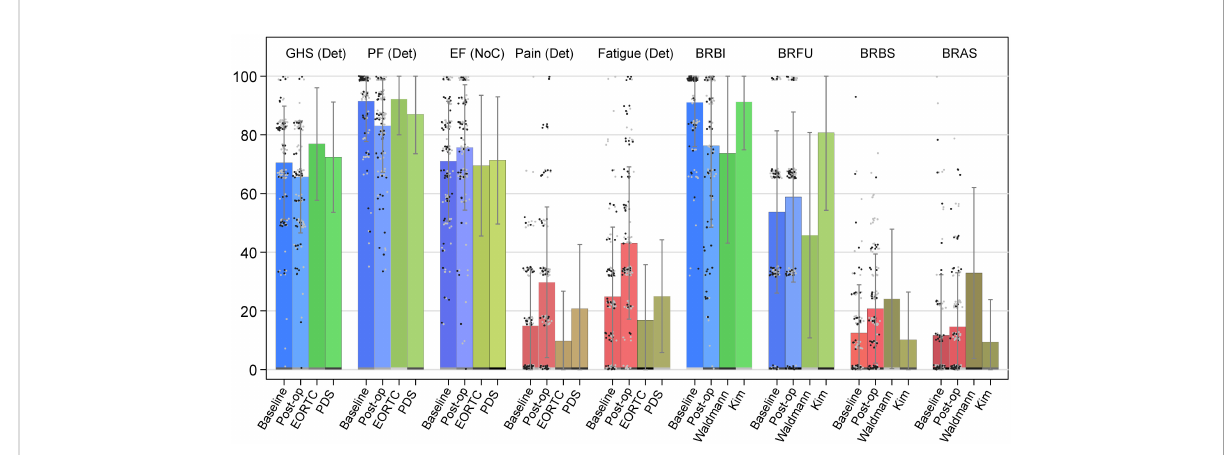
FIGURE 1 Bar chart of selected QLQ-C30 and QLQ-BR23 domain scores. Notes: ICO ICHOM data compared with reference values from Mierzynska et al. (2020) (EORTC and PDS) (26) and from Waldmann et al. (2007) and Kim et al. (2012); Error bars, standard deviation (SD); gray dots, patients without chemotherapy; black dots, patients with chemotherapy; GHS, global health status/QoL domain; PF, physical functioning domain; EF, emotional functioning domain; Pain, pain symptom domain; Fatigue, fatigue symptom domain; BRBI, body image; BRFU, future perspective; BRBS, breast symptoms; BRAS, arm symptoms; GHS, PF, EF, BRBI, and BRFU: Higher scores represent better health/HRQoL; Pain, Fatigue, BRBS, and BRAS: Higher scores represent more symptoms/poorer HRQoL. Of note, for QLQ-C30, Det, Imp, and NoC, Deteriorations, Improvements, and No Change indicate whether population mean score change reached minimal important difference (MID) and signi fi cance level of p- value<0.05 with the Wilcoxon signed-rank test for paired data. Baseline: ICO ICHOM data, baseline scores, measured at initial consultation for